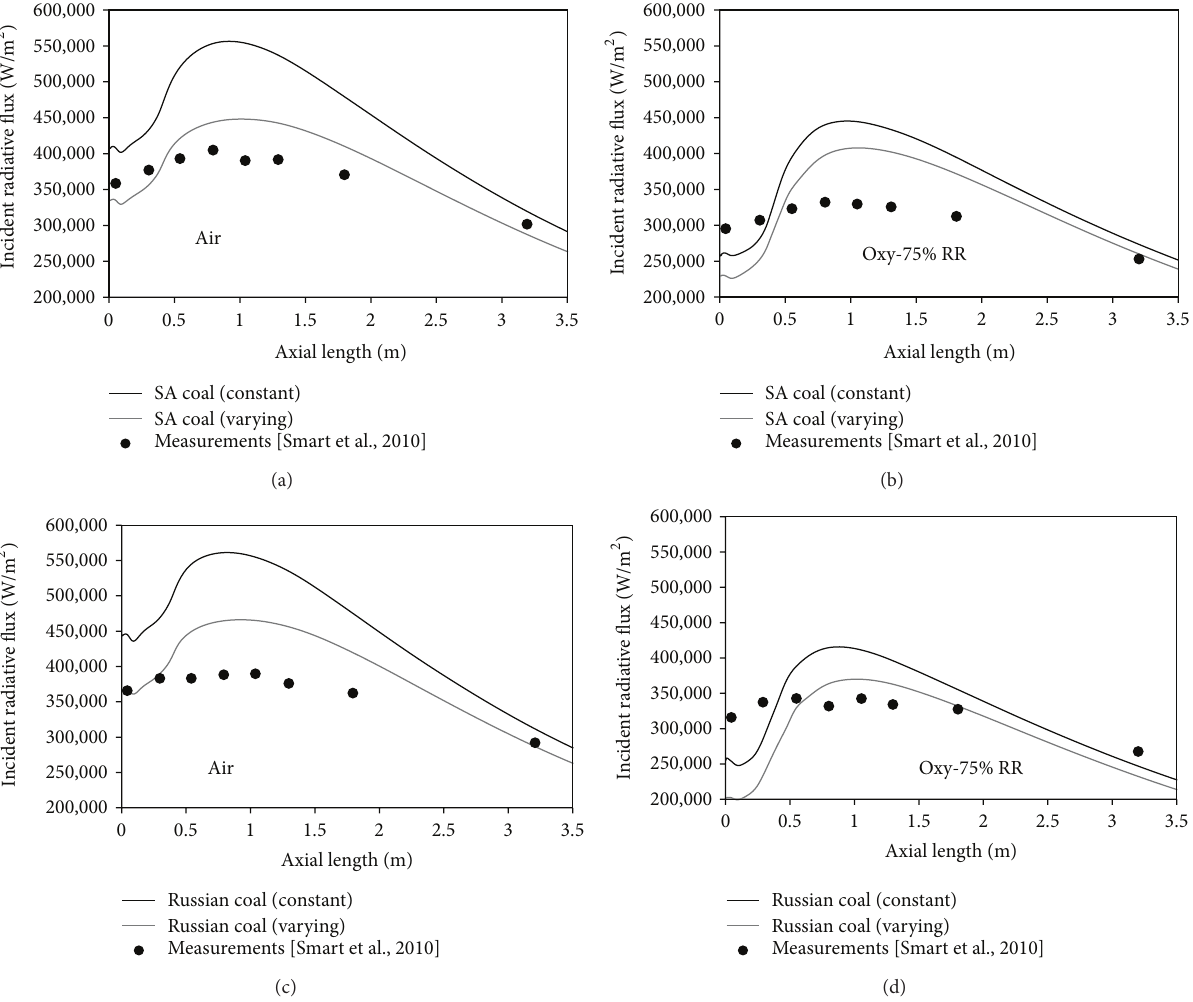
Figure 7: Wall incident radiative flux profiles predicted during the combustion of Russian and SA coals in air and in the oxy-75% RR scenario. Prediction sensitivities for employing “constant” and “varying” radiative properties are